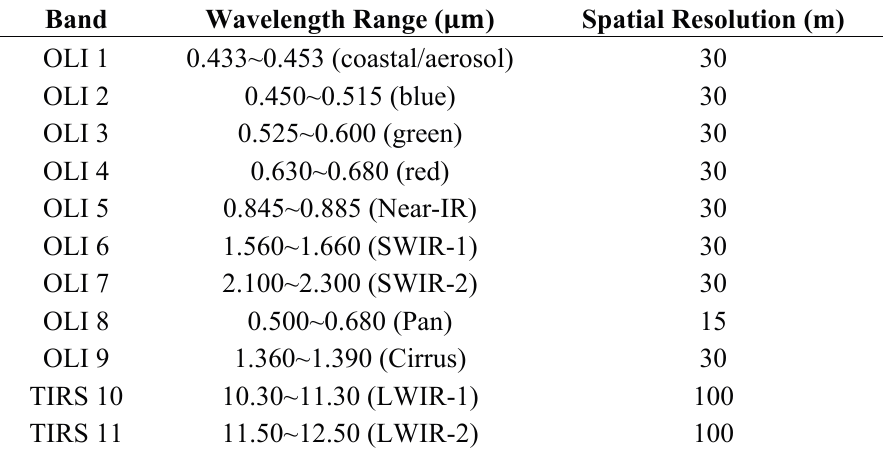
Table 1. Wavelength range and spatial resolution of the Landsat 8 OLI and TIRS